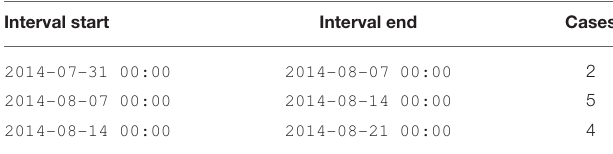
The interval start and end are inclusive and exclusive, respectively.